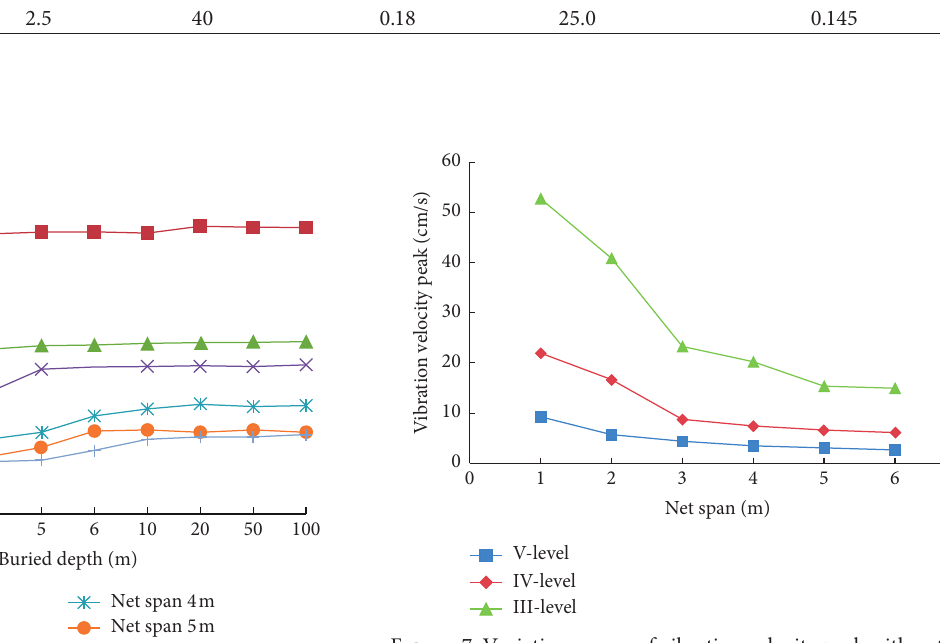
Figure 7: Variation curves of vibration velocity peak with net span under different surrounding rock